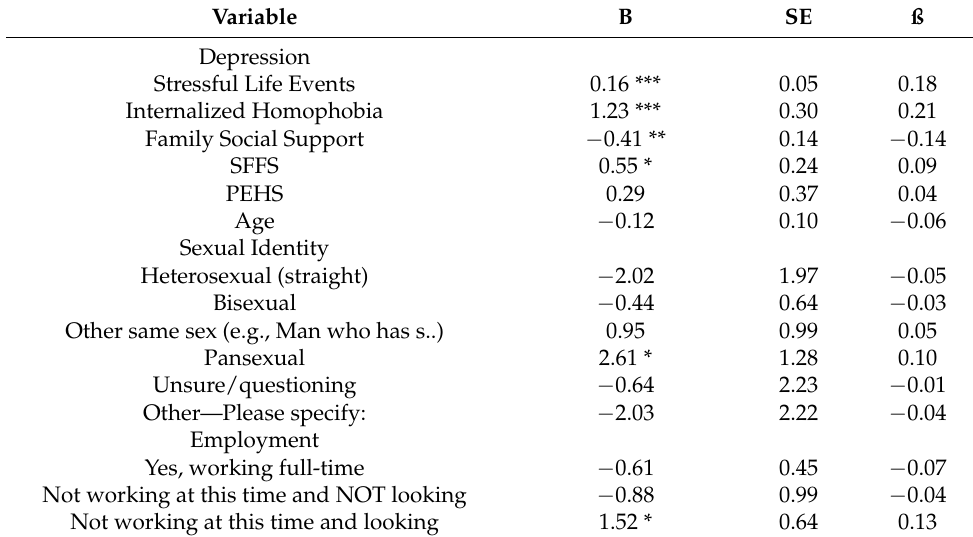
Table 3. Multiple regression on depression (N =